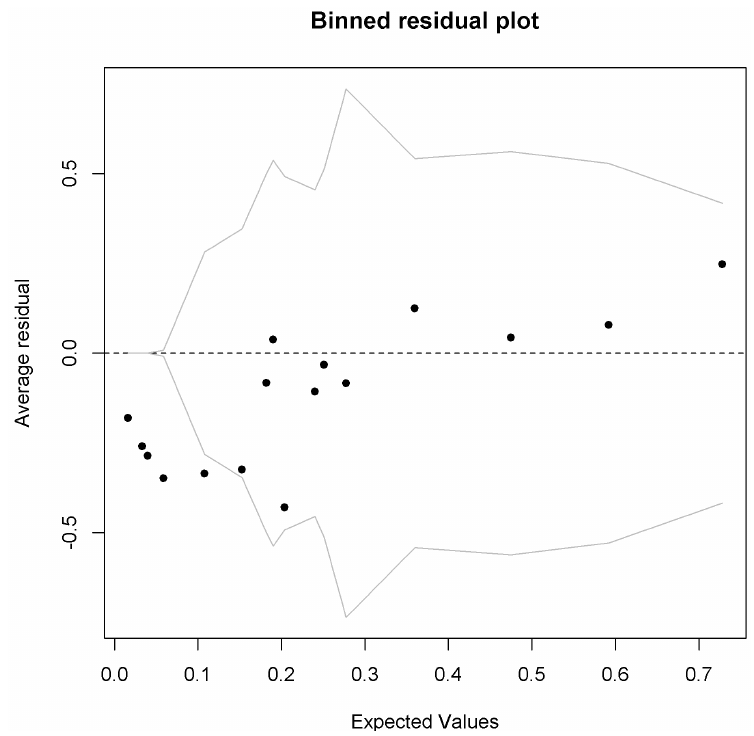
Figure A1. Residuals of the generalized linear model (binomial distribution) used to model seedlings probability to die. The analysis of models’ residuals showed that conditions for normality, homoscedasticity, and independency between observations were correctly met. All observations had Cook’s distances <1 indicating that no outliers influenced coefficient estimates.